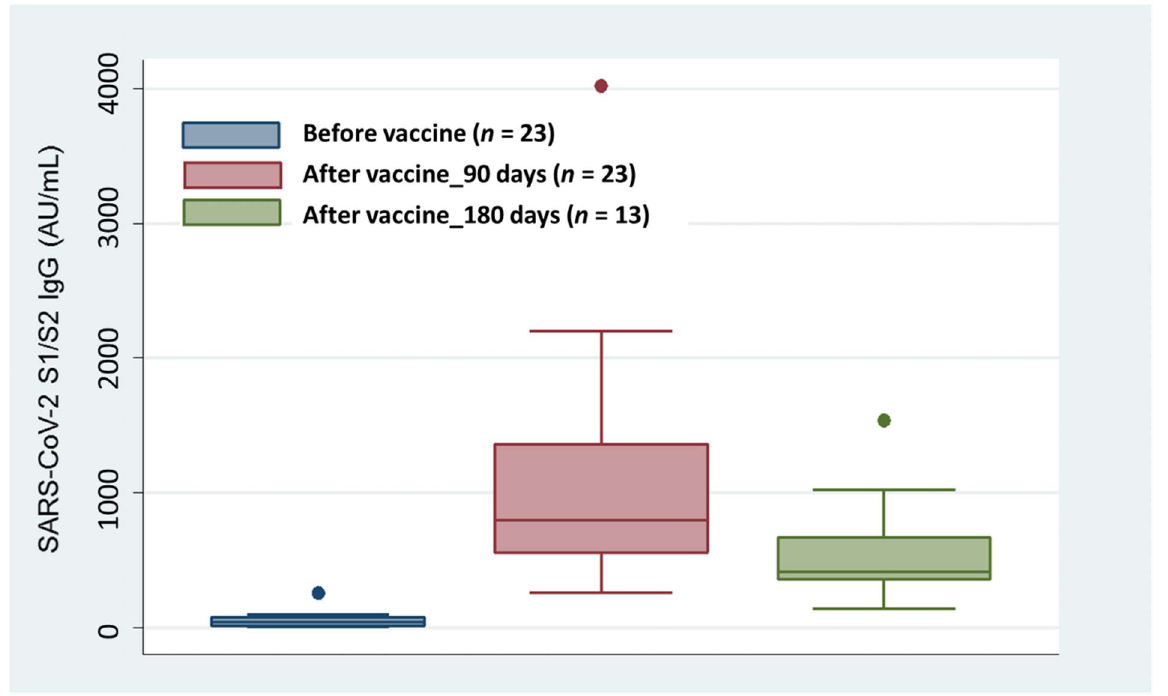
Figure 1. Box plot of SARS-CoV-2 S1/S2 IgG levels before vaccination and at 90 and 180 days following a 2-dose cycle with an mRNA-based vaccine in HD patients and KTRs.